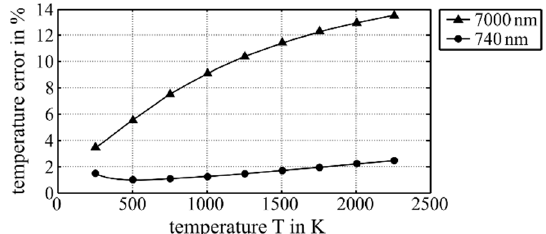
Figure 3. Relative error in temperature estimation using a 20% wrong emissivity value at the different wavelengths 740 nm (bandpass filter used during this research) and 7000 nm (usual wavelength for infrared thermal measurements). The figure is a result of Planck’s law and was calculated by numerical integration.